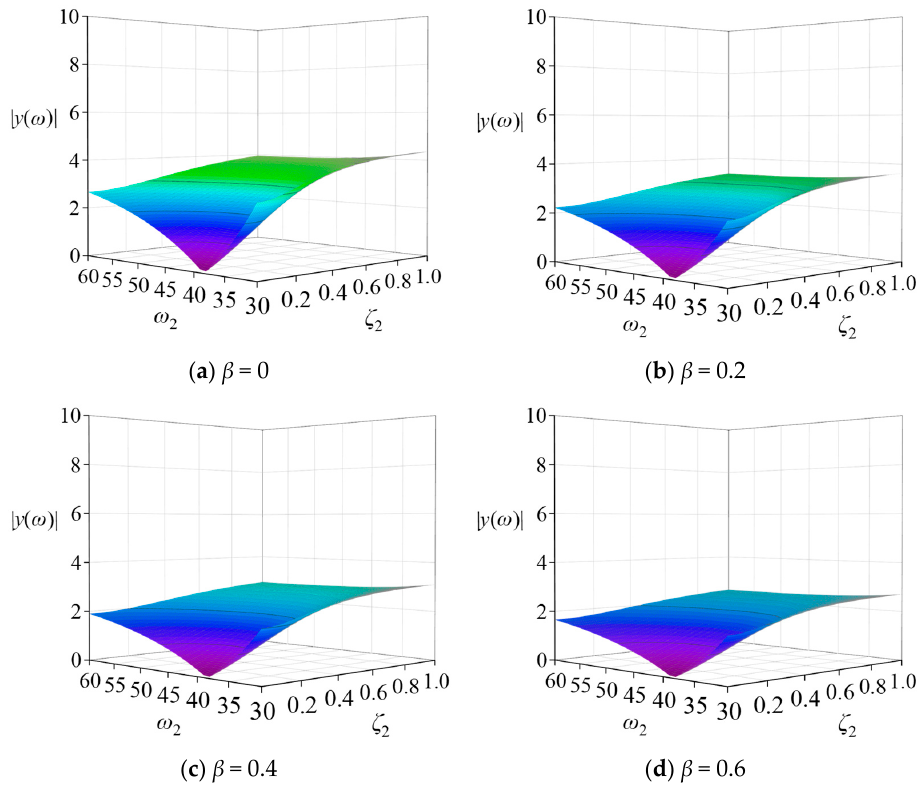
Figure 10. Variation of the maximum displacement in the span, μ =